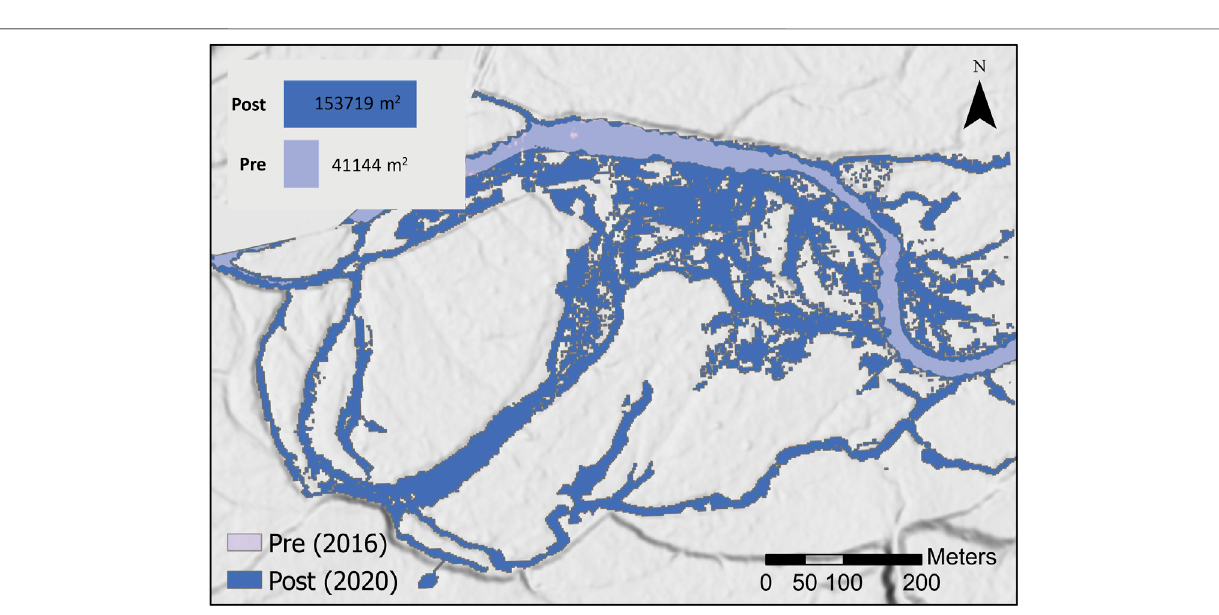
FIGURE 12 | Inundated area comparison pre- and post-restoration to a Stage 0 condition at the South Fork McKenzie River, OR. Visual overlay of the pre- treatment wetted area, based on early-summer 2016 imagery, compared to post-treatment wetted area, based on late-summer base- fl ow imagery. The background image is the LIDAR-derived DEM from 2020. Prior to restoration, the channel occupied only 41,114 m2 of area, as depicted on the northern edge of the image. In contrast, the post-restoration channel occupies not only a greater area, approximately 153,719 m2, but encompasses a landscape of over 400,000 m 2 in area.